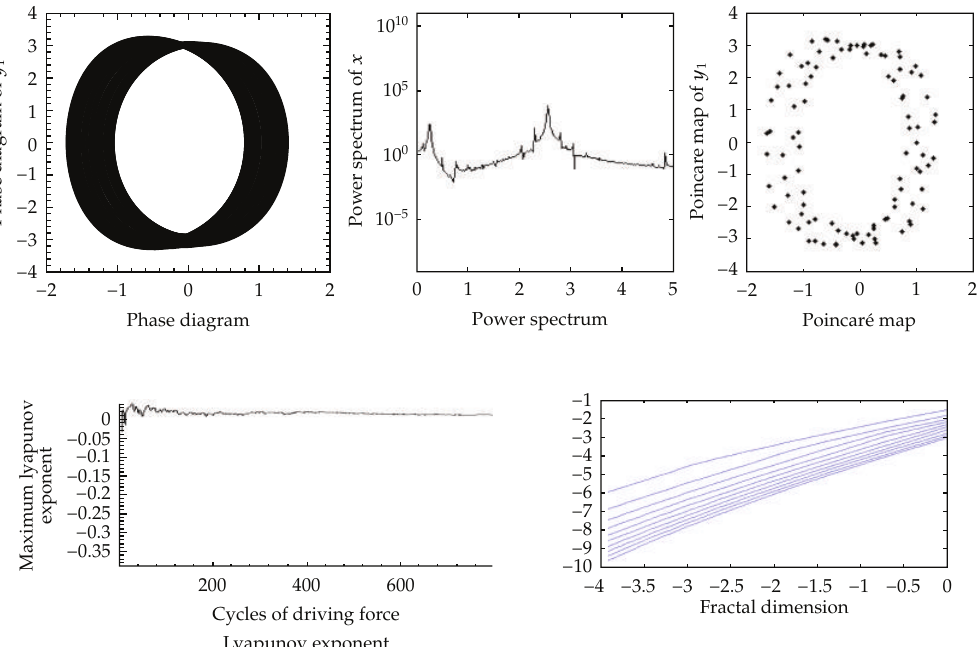
Figure 8: Simulation results obtained for gear-bearing system with s (cid:9) 1 . 0 for y 1 (cid:6) l ∗ (cid:9) 0 . 3 (cid:7)